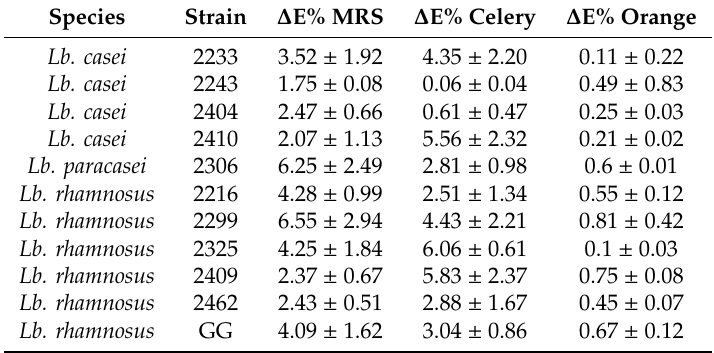
Table 4. Mean value of the measured ∆ E% value for each strain in MRS, Celery and